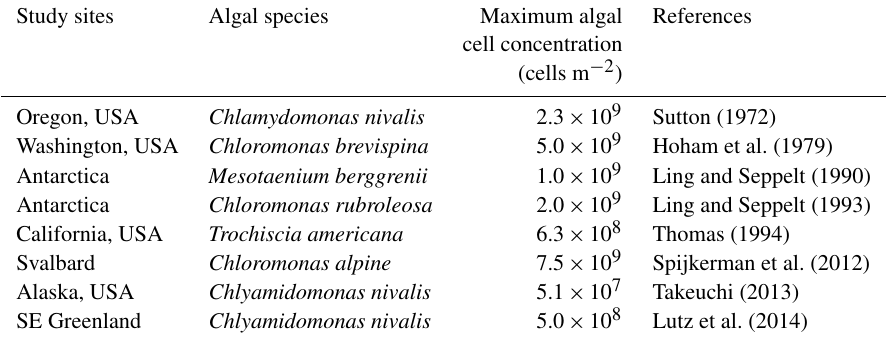
Table 2. List of maximum algal cell concentrations of red algal bloom reported from various snow fields across the world. Maximum algal cell concentrations per area (cellsm − 2 ) were obtained by calculation from reported maximum algal cell concentrations per volume (cellsmL − 1 ) assuming the snow density of granular snow to be 500kgm − 3 and the depth of collected samples to be